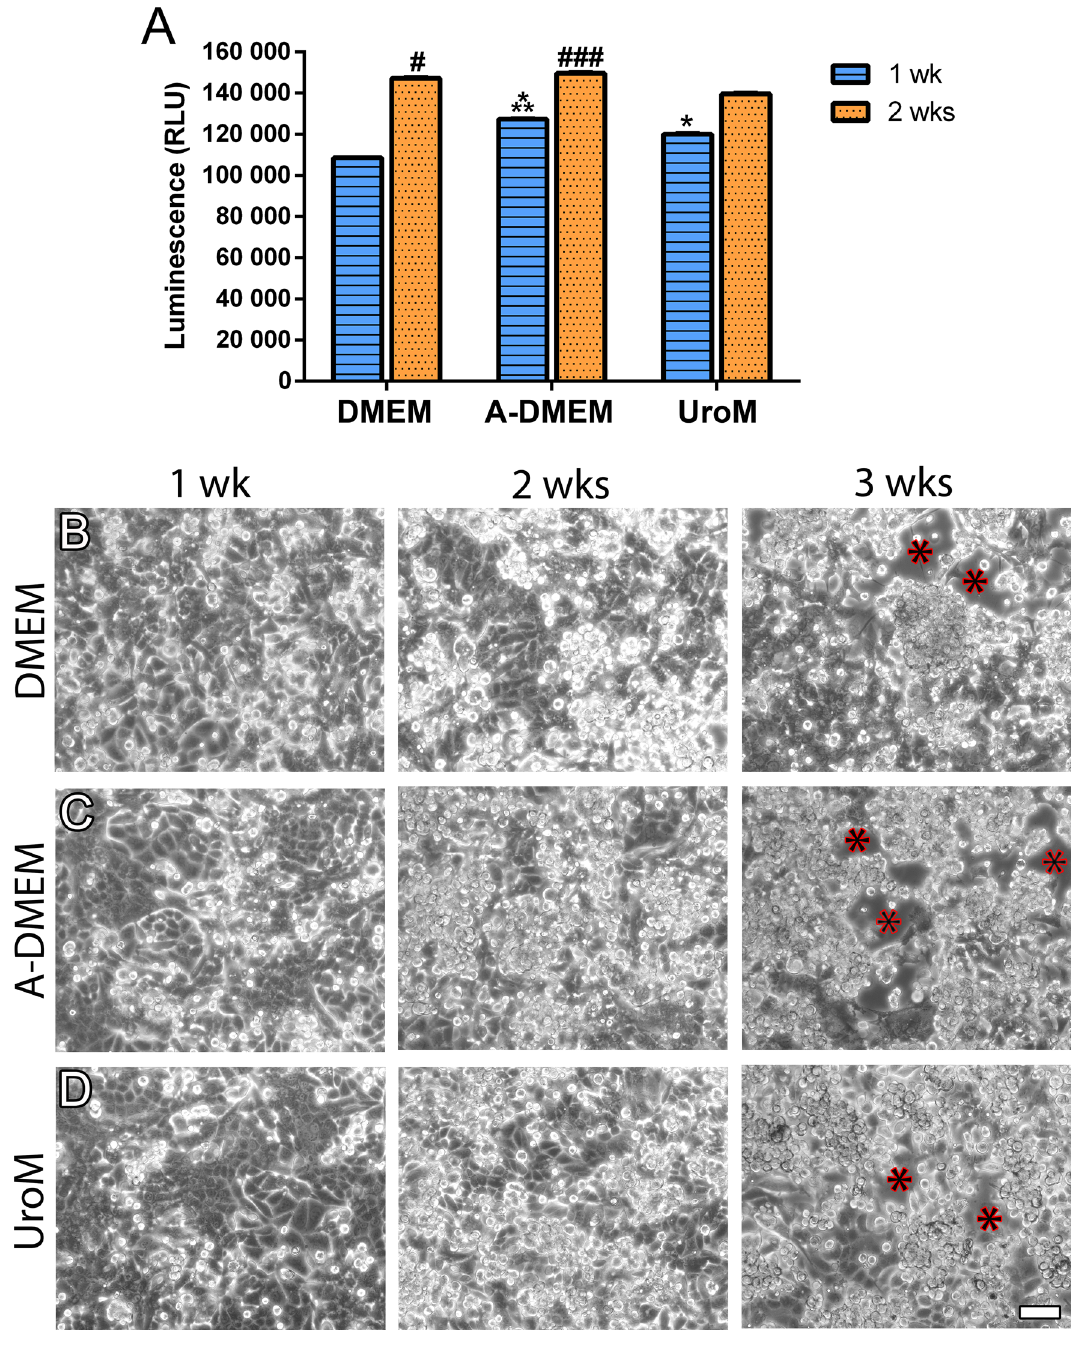
Figure 2. The viability of FLO-1 cells is high in all media, with FLO-1 cultures maintained in A-DMEM having the highest number of viable cells. However, with increasing culturing time, cell shedding is observed in all media types. ( A ) Cell viability was assessed by the determination of the cellular ATP level as an indirect measure of the number of viable cells. Bars represent the arbitrary relative luminescence units (RLU). Two-way ANOVA with Tukey’s multiple comparisons test was performed (n = 24 wells with cell cultures per medium type). ***After 1 wk in vitro, the number of viable cells is significantly higher in A-DMEM compared to DMEM ( p < 0.0001) and UroM ( p < 0.05) media. *The viability of cells maintained in UroM is significantly higher than in DMEM ( p < 0.0001) after 1 wk. ###After 2 wks the number of viable cells is significantly higher when cells are maintained in A-DMEM compared to DMEM and UroM ( p < 0.0001). #The viability of cells maintained in DMEM is significantly higher than in the UroM after 2 wks in culture ( p < 0.01). ( B ) Cells detach from the growth surface (polyethylene flasks) when maintained in culture for a prolonged time (red asterisks), regardless of culture media. Scale bar, 10